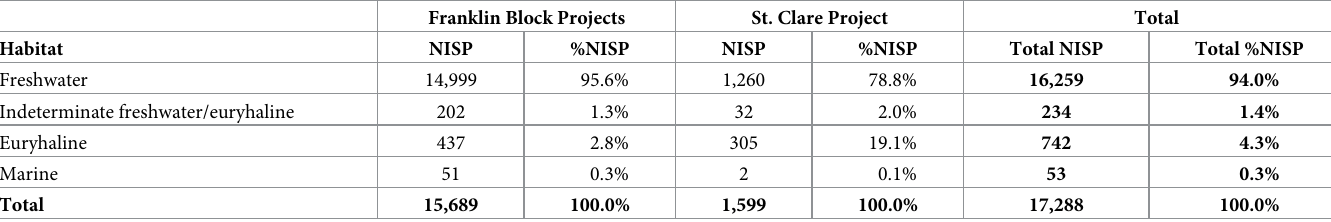
Table 1. Numbers of identified specimens (NISP) by habitat and project for fish remains at the Mission Santa Clara Rancheria archaeological